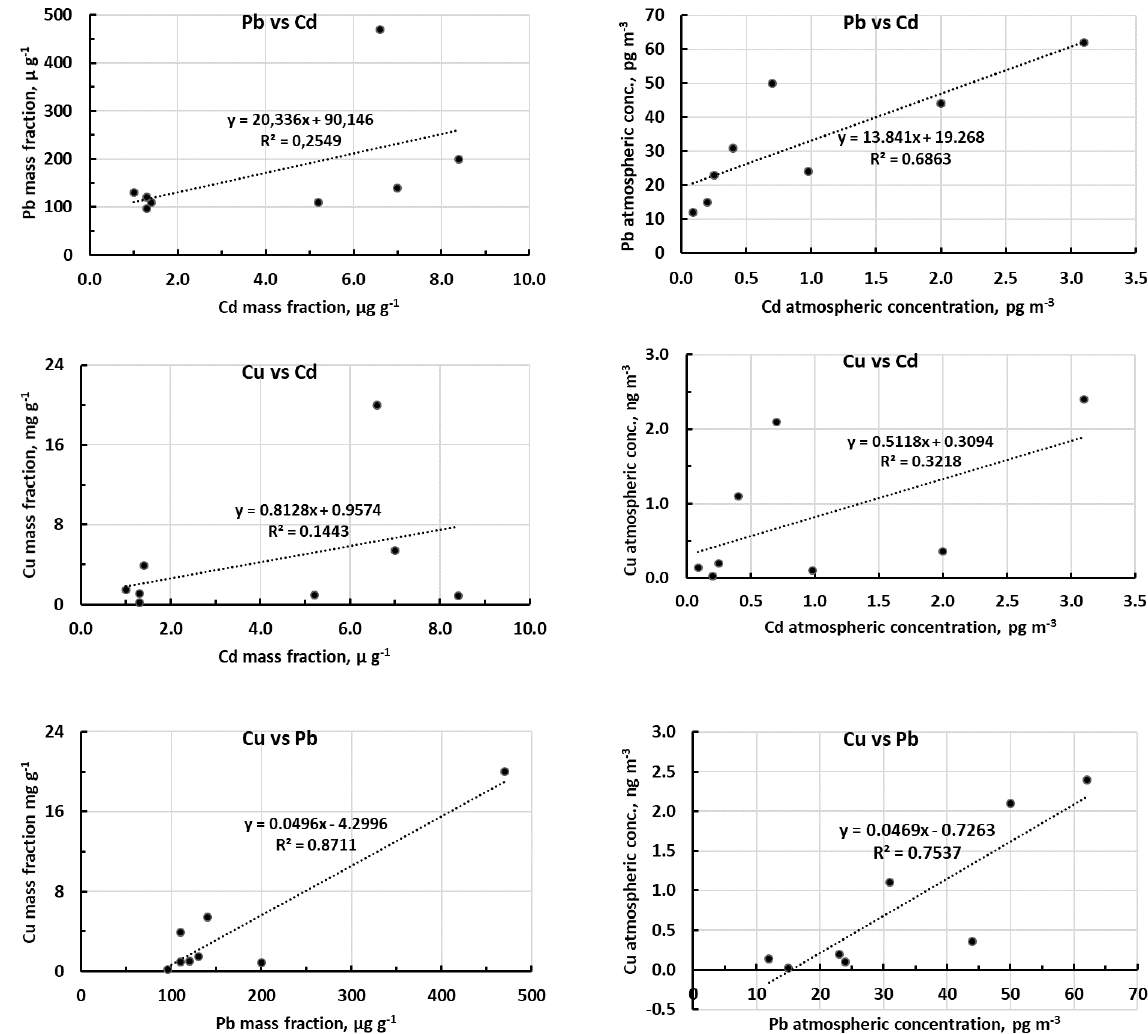
Figure 6. Bivariate scatter plots of metal contents (in mass fractions and atmospheric concentrations) in the aerosol samples collected at Dome C during austral summer 2005–2006. Table 4. Correlation coefficients ( r ) and significance ( p -value) between metal contents in samples of the background series (CS-2, AT1-2, AT1-3, AT2-2) and in those affected by the station activities (CS-1, CS-3, AT1-1, AT2-1). One-tailed t -test is used since the interest is for r > 0.